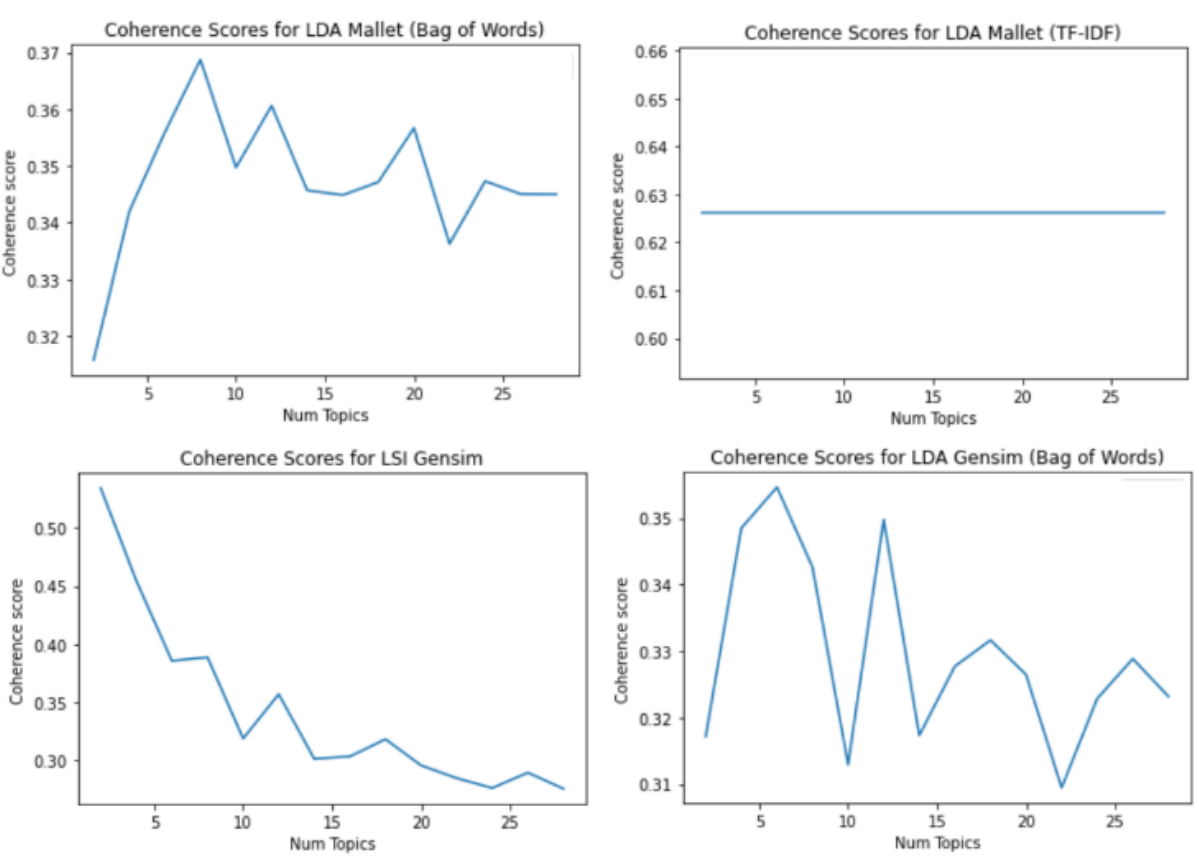
Figure 8. Topic model s’ coherence scores curves for the SIGIR dataset.